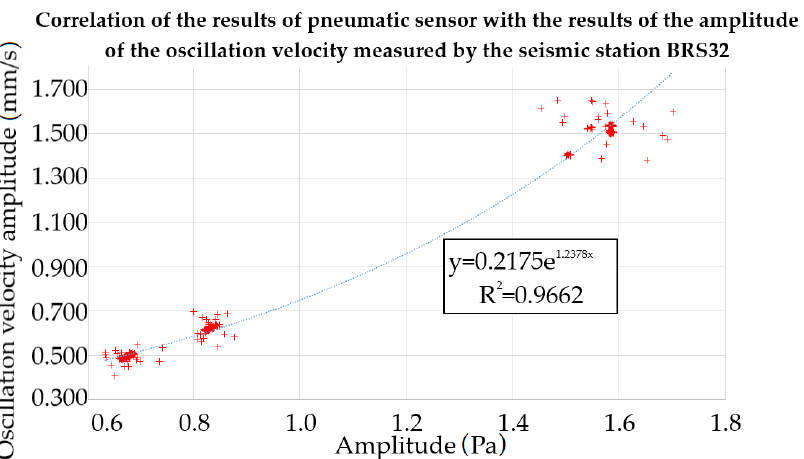
Figure 12. Mathematical relationship for the pneumatic